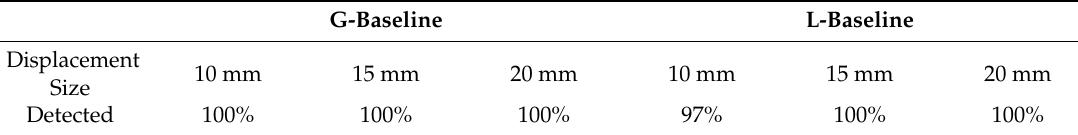
Table 10. Detection of 3D